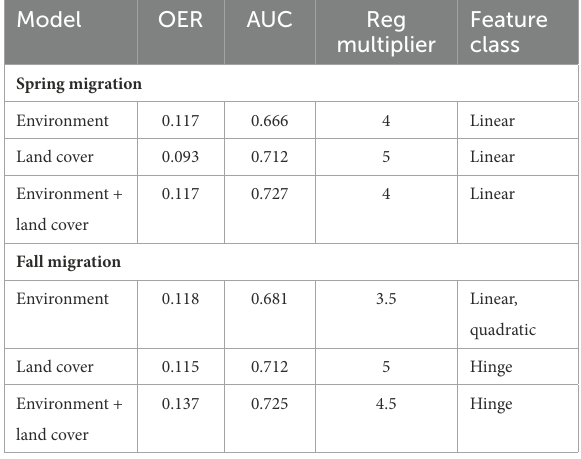
“OER” lists the omission error rate on test data for each of the models, “AUC” lists the area under the ROC curve for test data, “Reg Multiplier” and “Feature Class” show the regularization multipliers and Maxent feature classes used for each